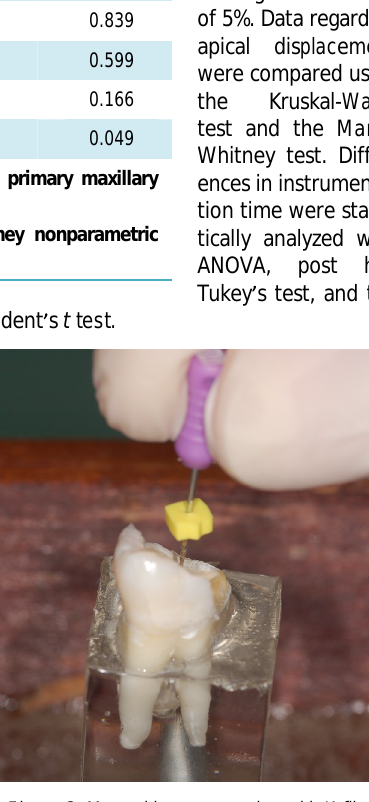
Figure 3: Manual instrumentation with K-files.